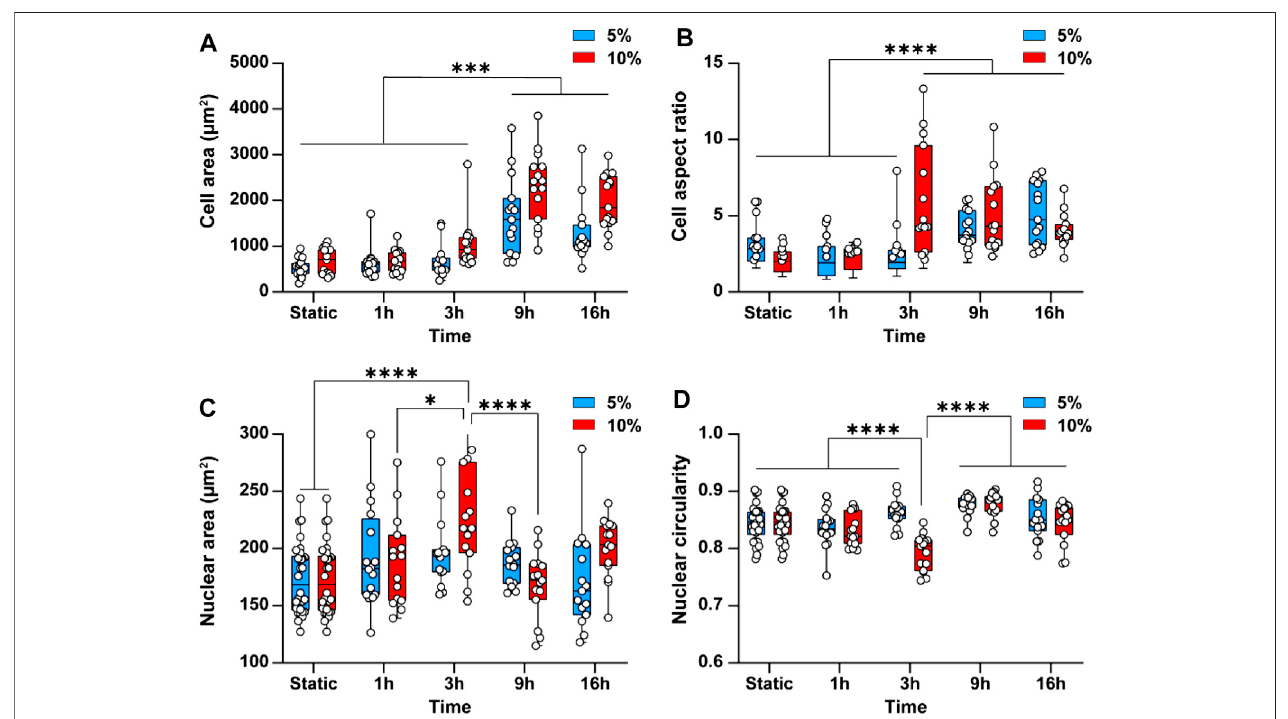
FIGURE4| Cyclic stretchchangesthemorphologyofendothelial cellsand thecell nucleus. Bargraphsshowingthedifferences in (A) Cellareaand (B) Cellaspect ratio (C) Averagenuclearareaand (D) Averagenuclearcircularitywhensubjectingcellsto5and10%cyclicstretchfordifferentexposureperiods.Circlesrepresentsingle cells. Boxes show median and fi rst and third quartiles. * indicates p < 0.05, ** indicates p < 0.01, *** indicates p < 0.001 and **** indicates p <